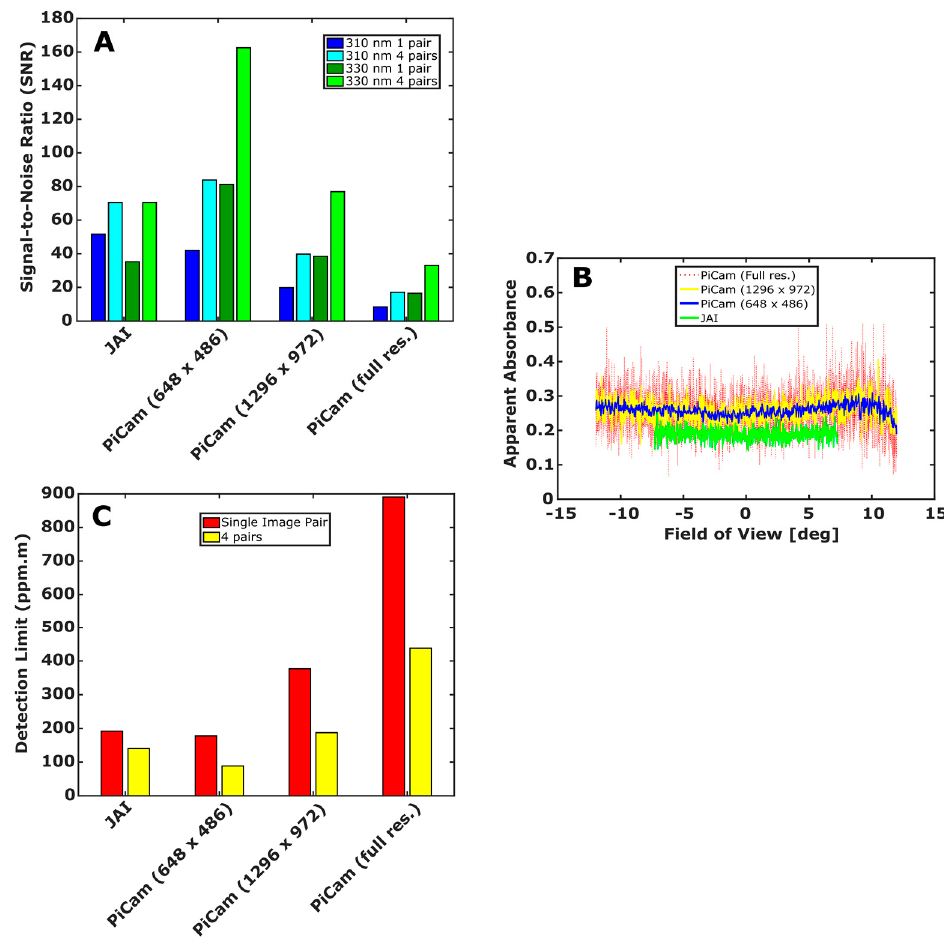
Figure 4. ( A ) Signal-to-noise ratios (SNRs); ( B ) Cross sections over apparent absorbance images for a SO 2 cell (1861 ppm · m); ( C ) Detection limits for the JAI and PiCam systems with equivalent exposure times. For the PiCams, we examined both binned (648 × 486 and 1296 × 972) and full resolution (2592 × 1944) arrays. The former binning scenario provides approximately equal pixel resolutions across both systems (the JAI camera has a narrower FOV); the latter binning scenario provides approximately the same FOV per pixel from both systems. Four images were also co-added to increase SNR in ( A , C ) by summing four successive images on a pixel-by-pixel basis; results from this process are displayed as “4 pairs” entries. The drop in PiCam apparent absorbance at FOV > 10 ◦ is a manifestation of the gas cell holder entering the edge of the camera’s field of view and thus can be neglected. The 648 × 486 binning scenario, which we consider to provide sufficient spatial resolution for volcanic gas monitoring applications, provides comparable performance to the JAI cameras in these experiments. See main text for full details.